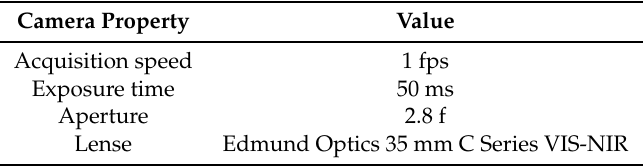
Table 2. Camera parameters chosen for the